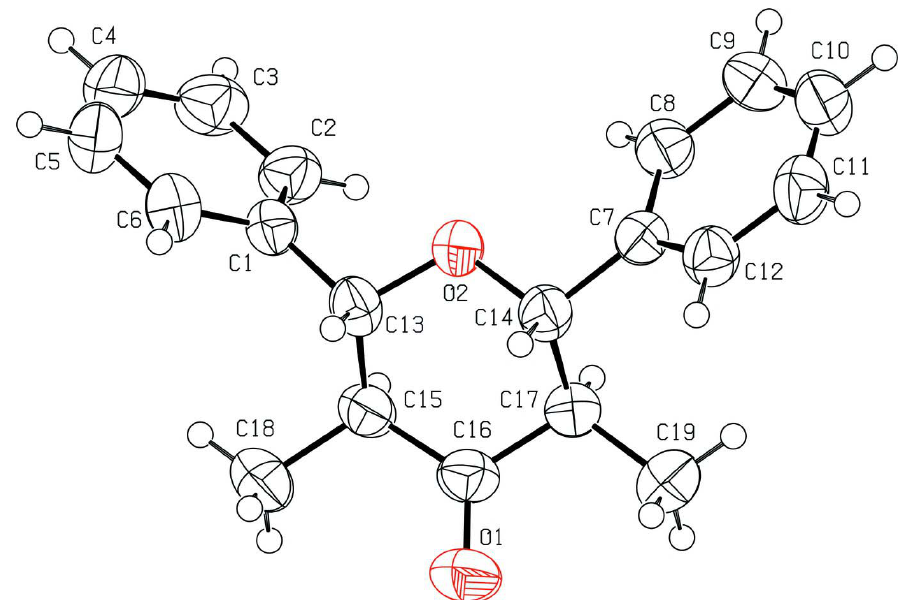
The molecular structure of the title compound, showing 50% probability displacement ellipsoids and the atom-numbering